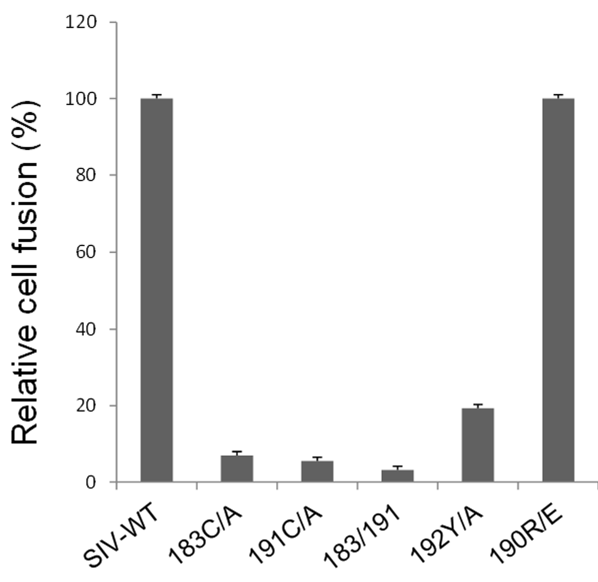
Figure 3. Cell-cell fusion mediated by SIVmac239 Env variants. The cell-cell fusion assay was performed by measuring the fluorescence intensity of Tat-inducible luciferase resulting from fusion of the SIVmac239 Env-expressing cells with target TZM-bl cells.